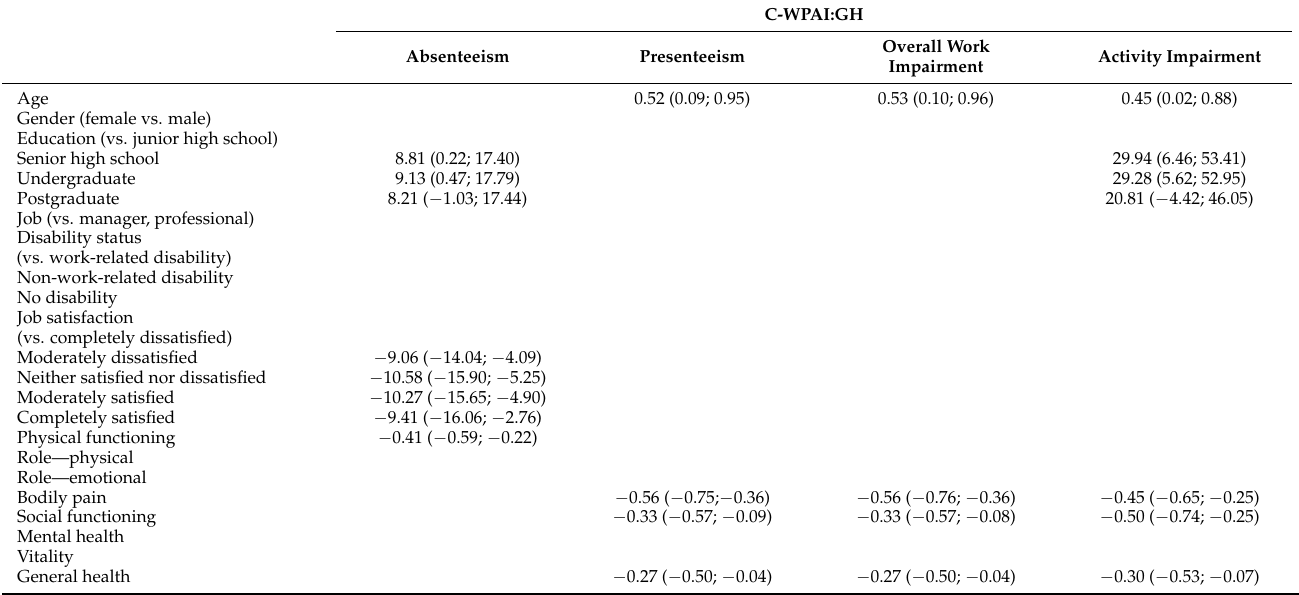
Table 5. Factors correlated with the C-WPAI:GH using Bayesian model averaging (regression coeffi- cient β and 95% credible interval (95%